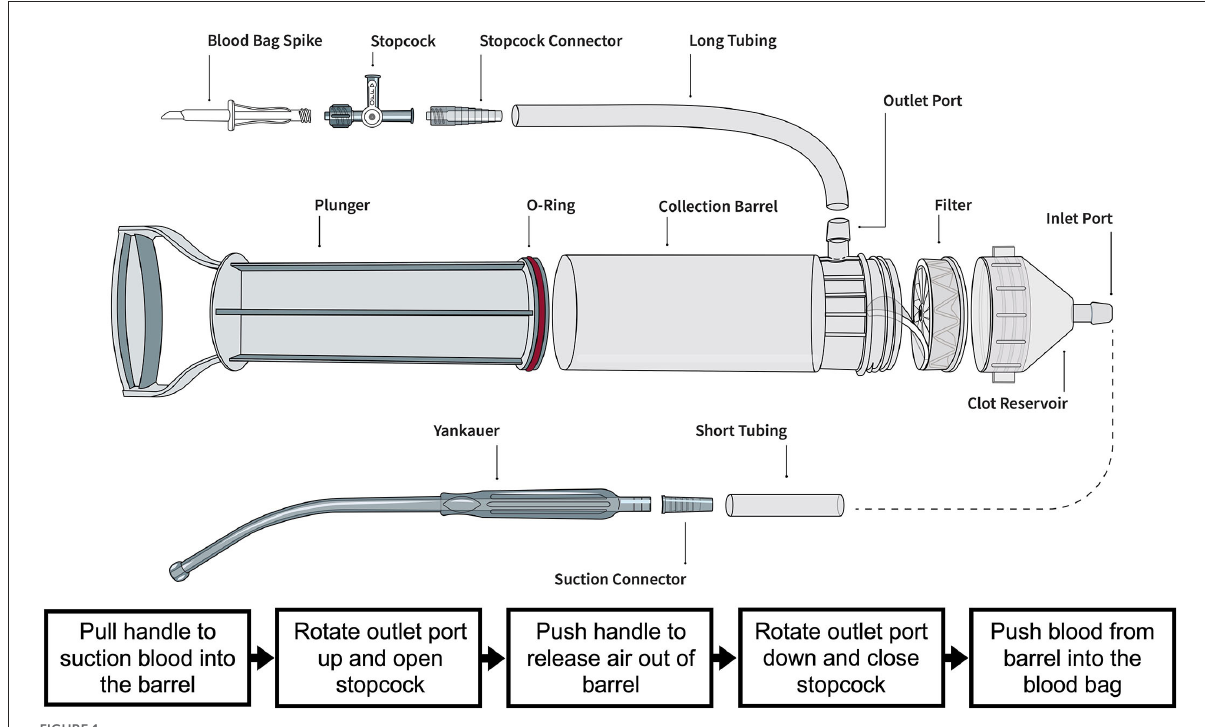
FIGURE1 Illustration of the Hemafuse device and the individual parts courtesy of the Sisu Global (https://sisuglobal.health/brochures). Beneath the illustration is a step-by-step procedure on how to use the device: (1) Pull the handle to suction blood into the barrel, (2) ensure the outlet port up, and open the stopcock, (3) push the handle to release air out of the barrel, (4) rotate outlet port down, and close stopcock, and (5) push blood from the barrel into a heparinized blood bag.